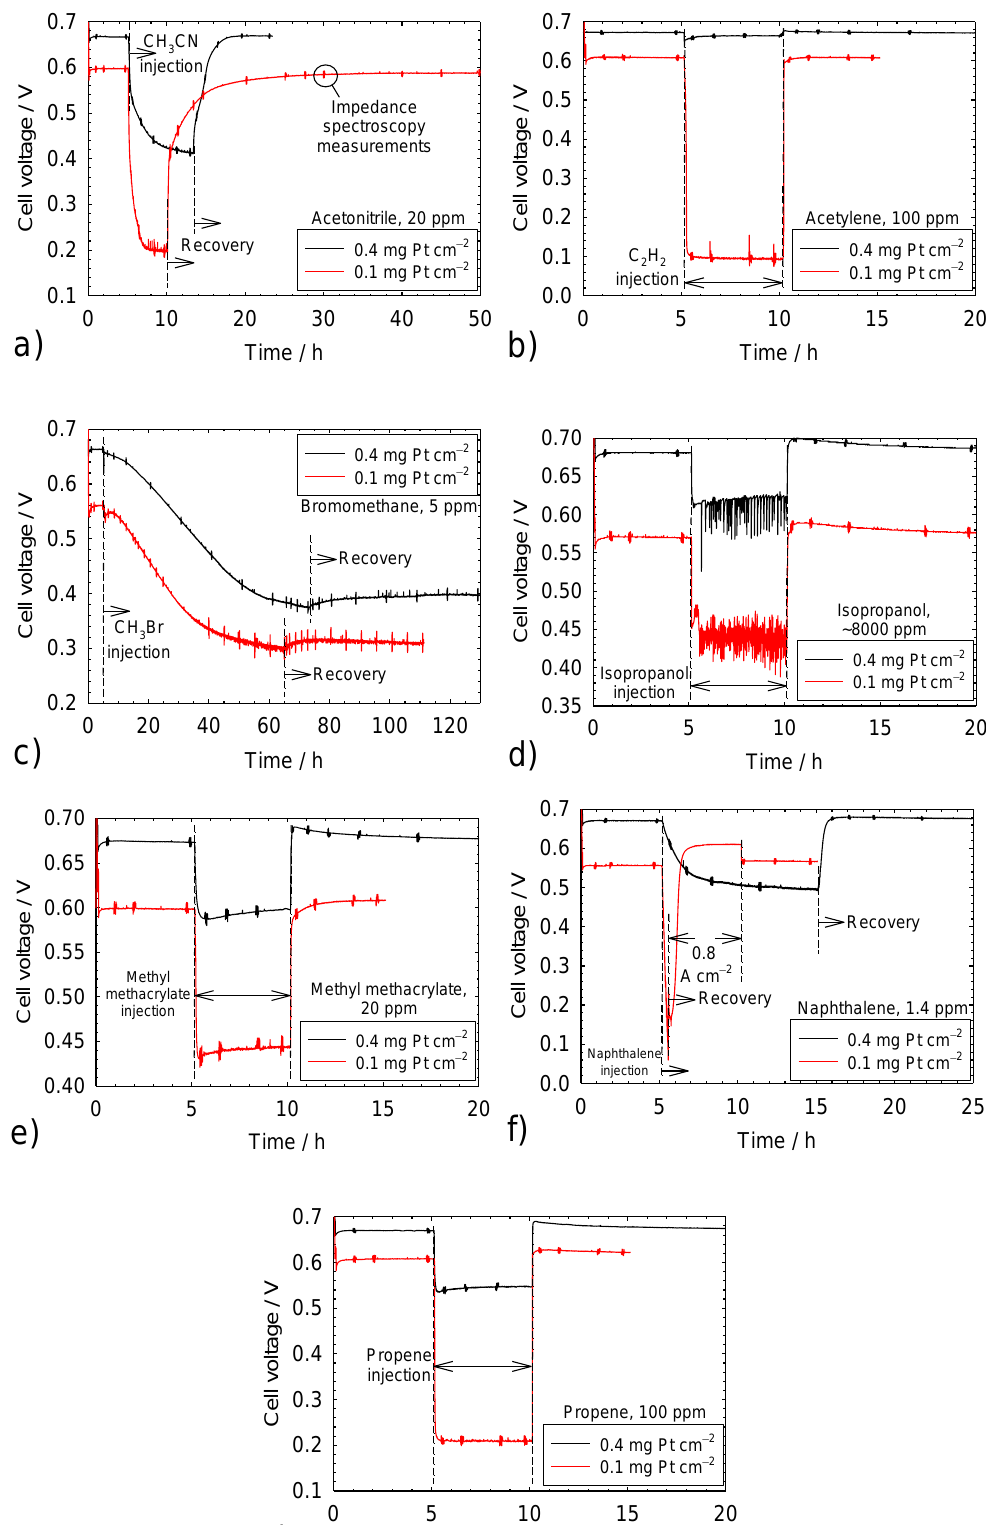
Figure 1. Cell voltage transients resulting from a temporary contaminant injection. ( a ) Acetonitrile; ( b ) acetylene; ( c ) bromomethane; ( d ) isopropanol; ( e ) methyl methacrylate; ( f ) naphthalene; ( g ) propene.